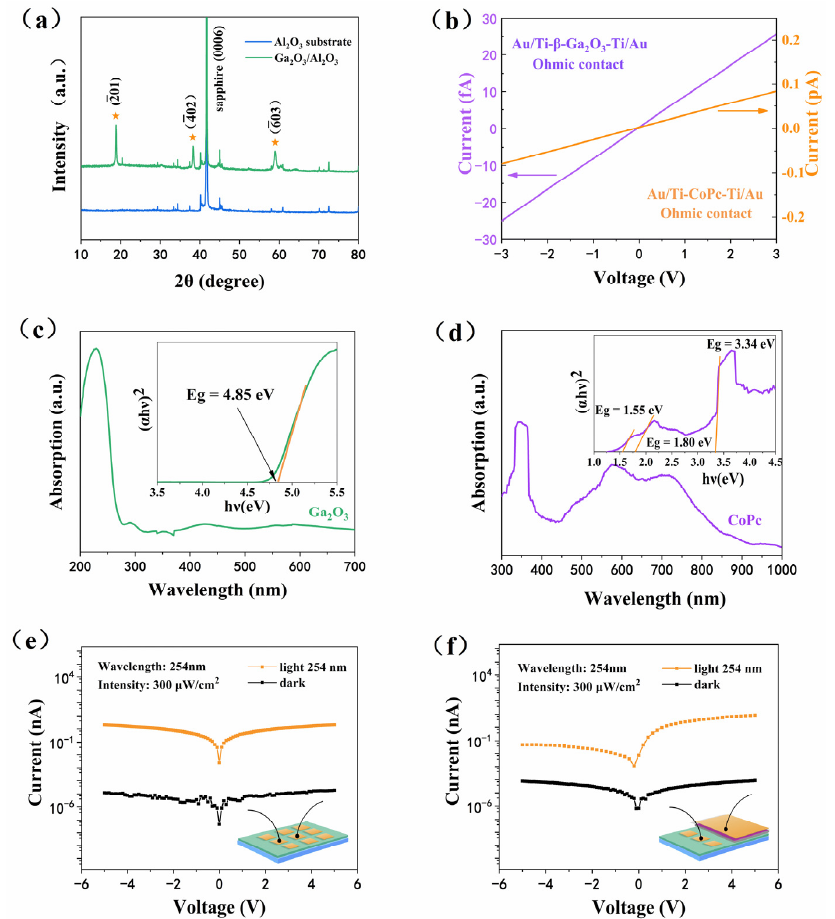
Figure 2. ( a ) The XRD patterns of Ga 2 O 3 /Al 2 O 3 films by MOCVD. ( b ) The I-V curves of Au/Ti-Ga 2 O 3 -Ti/Au and Au/Ti-CoPc-Ti/Au under dark. The optical absorption curves of ( c ) Ga 2 O 3 film and ( d ) CoPc film; inserts represent the estimated bandgaps. The semi-log scale I-V curves of ( e ) Ga 2 O 3 film and ( f ) CoPc/Ga 2 O 3 heterostructure.